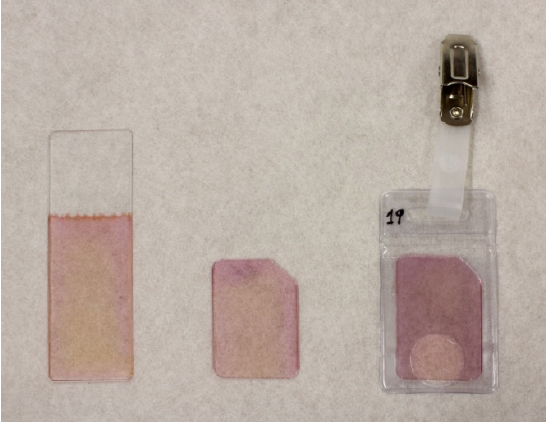
Figure 1. Aspect of a pH sensor obtained from the glass slide, coated, cut, polished and finally protected by a polyethylene bag and provided with a gripper.